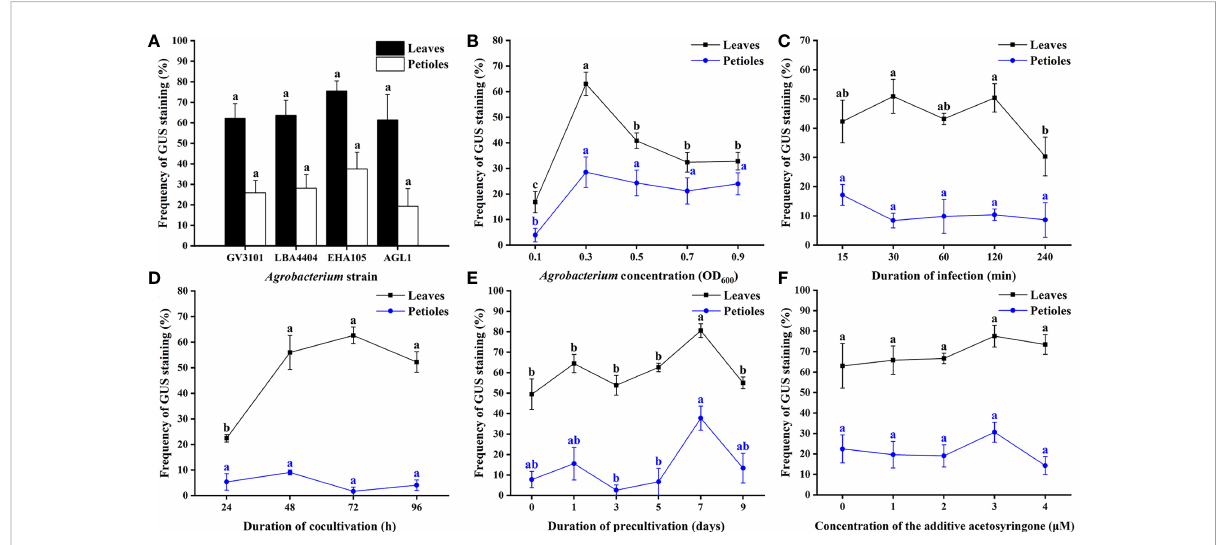
FIGURE 6 Optimization of Agrobacterium -mediated genetic transformation of E. urophylla × E. grandis DH32-29. Effect of (A) Agrobacterium strain, (B) Agrobacterium concentration, (C) duration of infection, (D) duration of cocultivation, (E) duration of precultivation, and (F) concentration of the additive acetosyringone on the transformation rate. Different letters indicate signi fi cant differences among treatments using Duncan ’ s multiple range test at p <